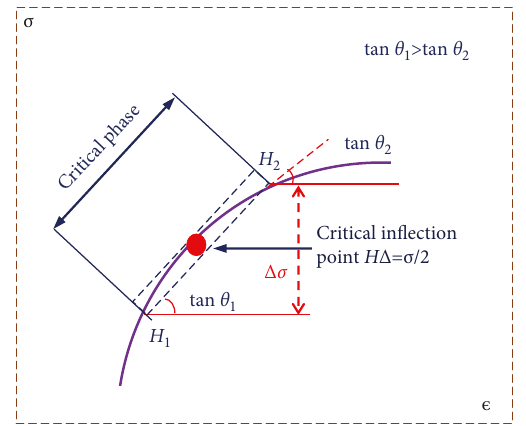
Figure 7: The relationship between the critical in fl ection point stress value and the degree of heterogeneity of the soft coal